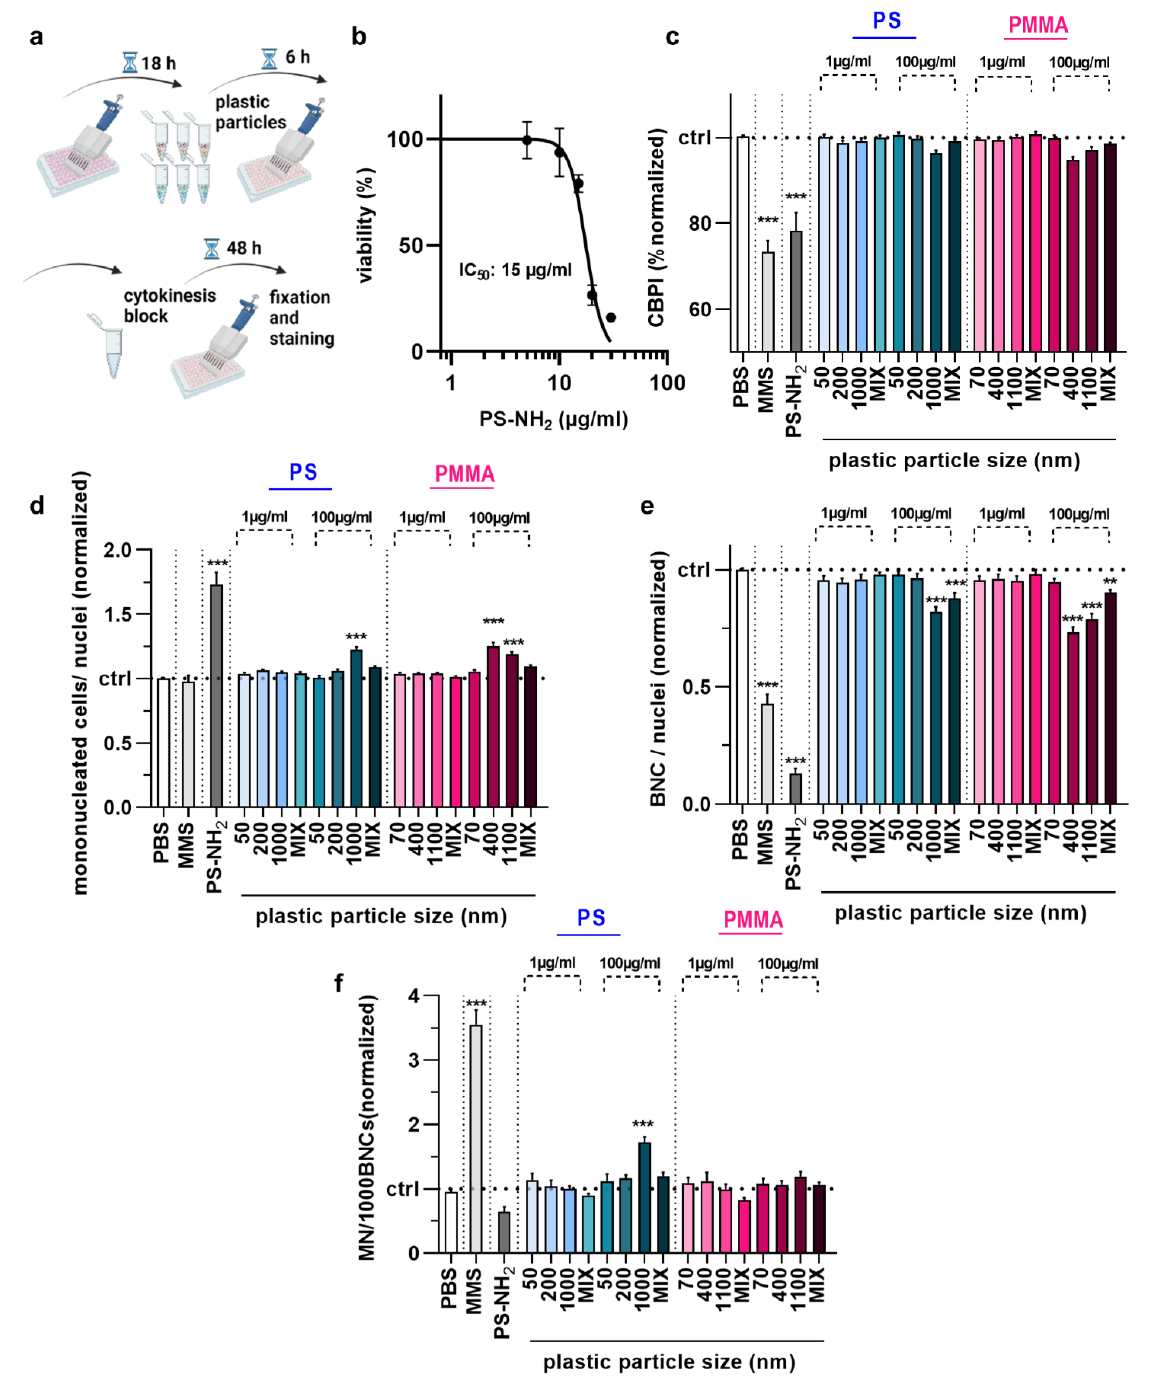
Figure 3. Acute toxicity and genotoxicity testing in HaCaT keratinocytes upon polymer particle exposure. ( a ) Acute particles exposure scheme; ( b ) aminated (PS-NH 2 ) polystyrene (PS) particle dose–response curve 54 h post-exposure; ( c – f ) CBPI ( c ), number of MNCs ( d ), number of BNCs ( e ), and MN frequency per 1000 BNCs ( f ) in HaCaT keratinocyte samples exposed to vehicle (PBS), MMS (positive control for genotoxicity), PS-NH 2 particles (positive control for polymer toxicity), and PS and PMMA polymer particles of different sizes (50–1100 nm) and concentrations (1 µg/mL and 100 µg/mL). Data are representative or mean + SEM from at least six independent experiments. Statistical analysis was performed using one-way analysis of variances with Dunnett post hoc testing for multiple comparisons ( c , d , e , f ) with ** = p < 0.01 and ***= p < 0.001.